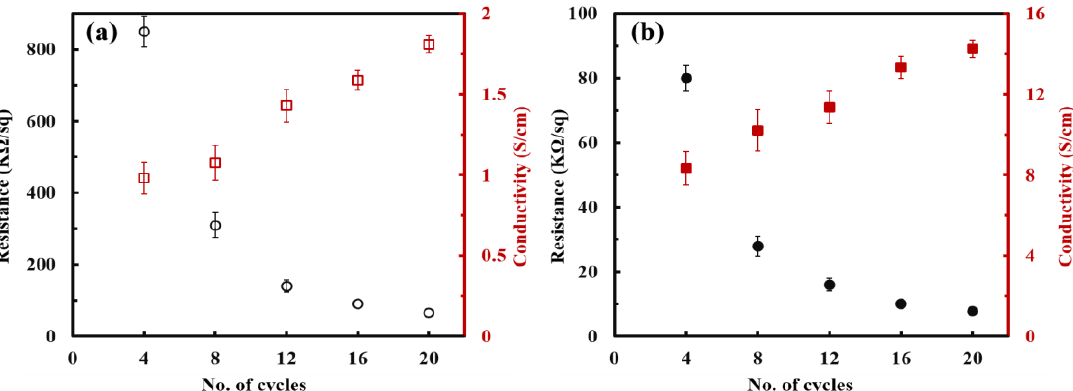
Figure 4. Sheet resistance and electrical conductivity of PANi/SWNT-PEDOT:PSS thin films that are coated by ( a ) traditional dipping and ( b ) spraying method.